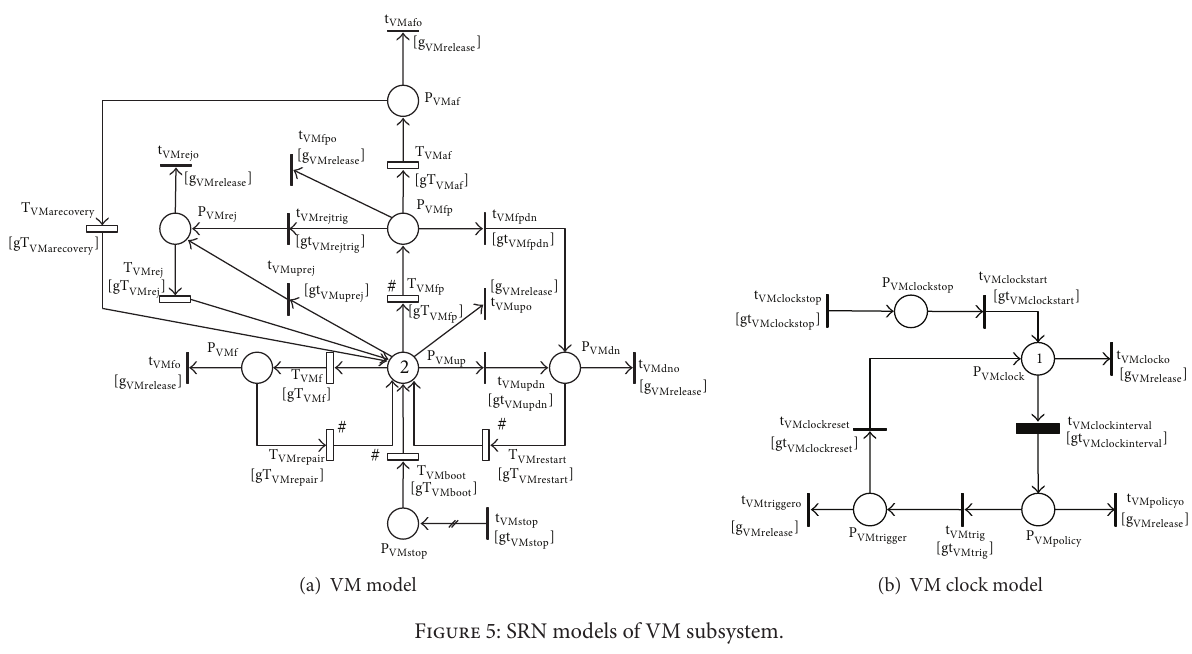
Figure 5: SRN models of VM subsystem.